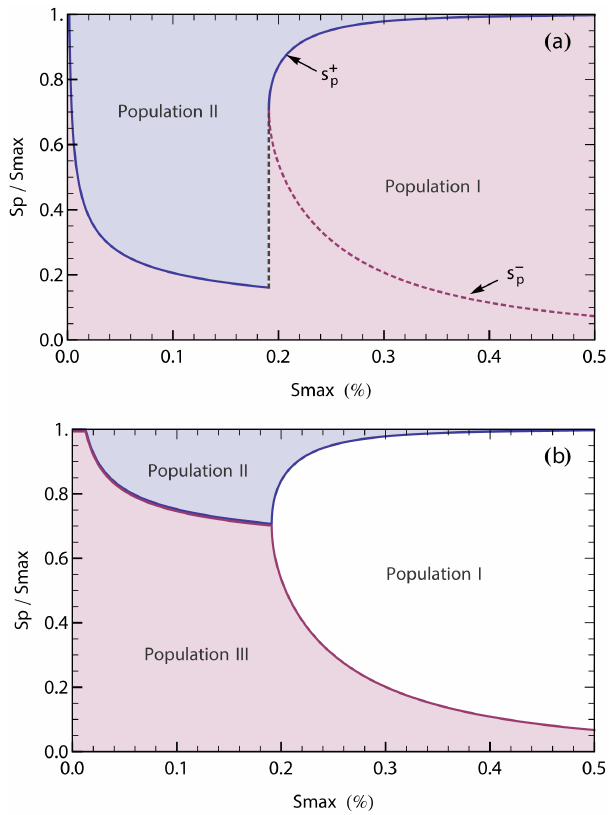
Figure 1. The “partitioning supersaturations” s ± p illustrated in the s c – s max space. (a) The s c – s max space as used in Nenes and Seinfeld (2003) and Barahona et al. (2010); and (b) as used in this study. The example here is for a vertical velocity w = 0 . 1ms − 1